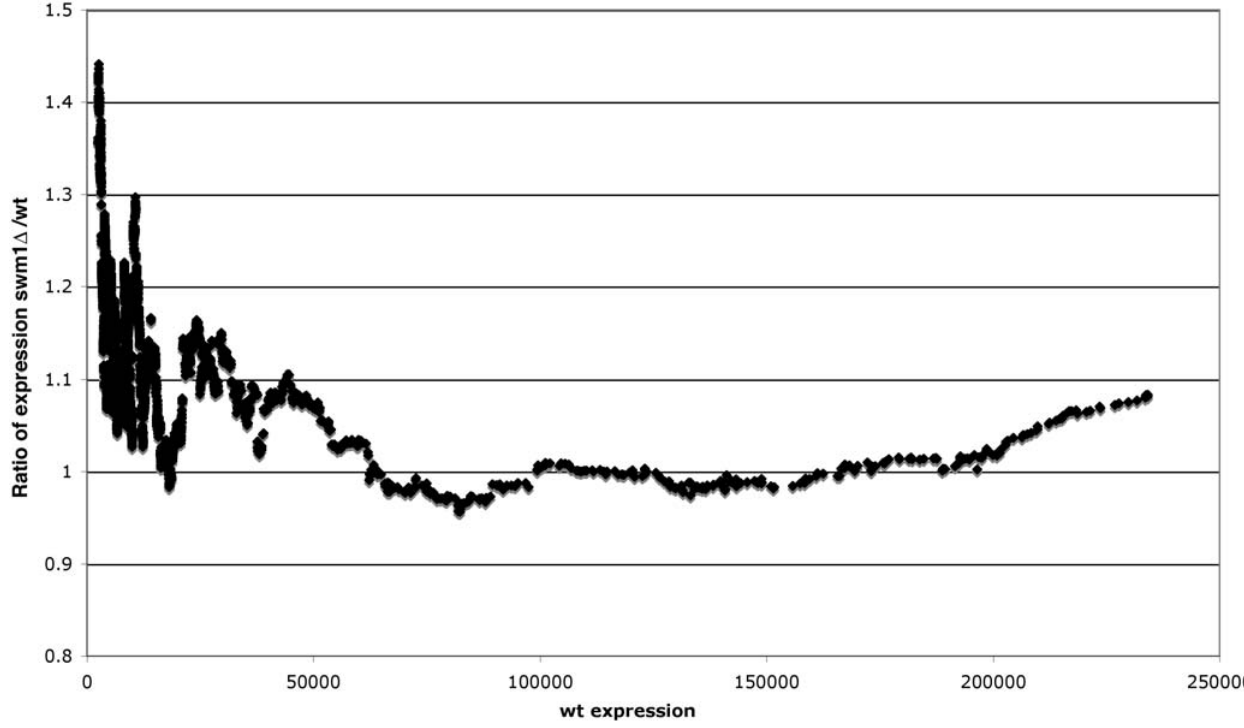
Figure 3 . Global analysis of the gene expression profile in swm1 vs wild type cells. A moving average plot (window size=150 genes, step size=1 gene) of the median gene expression ratio, swm1 D /wt, plotted as a function of the average transcription levels of 11 wild-type cell cultures in mid- logarithmic growth.